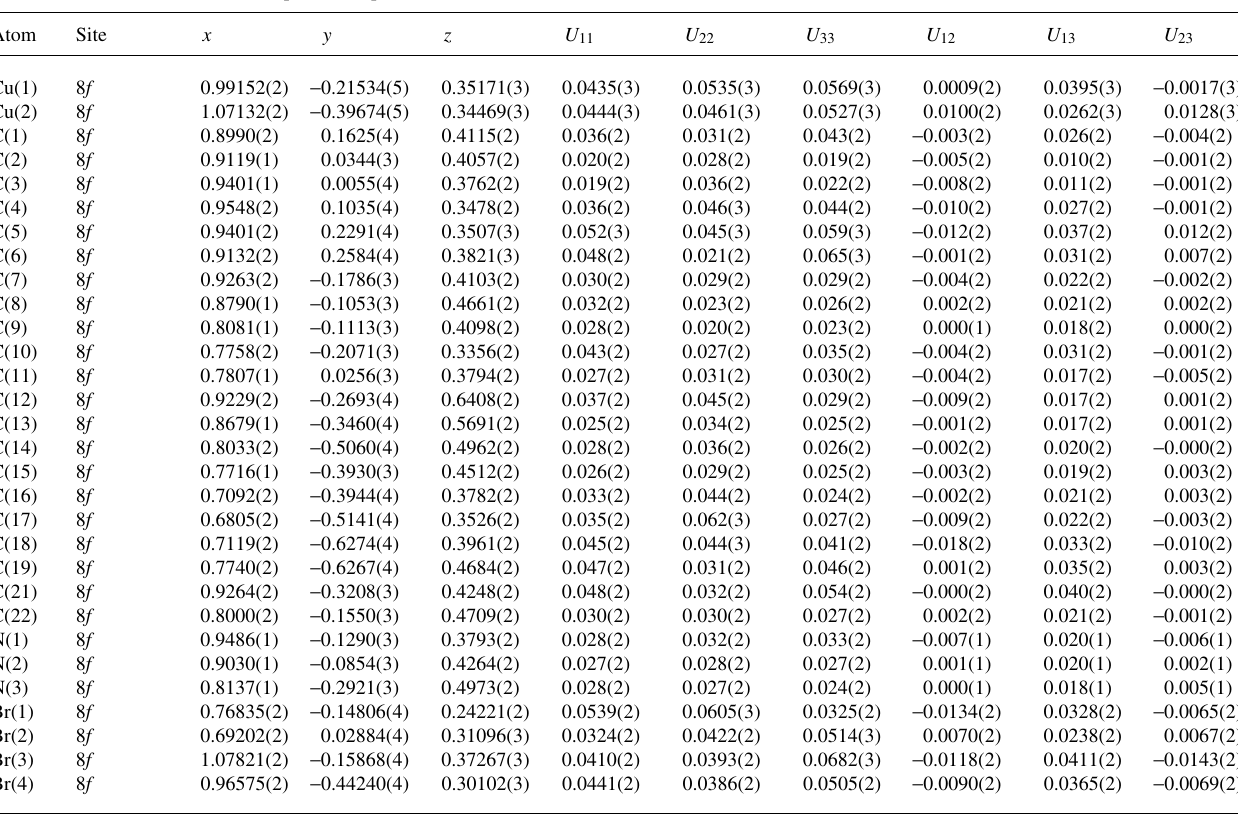
Table 3. Atomic coordinates and displacement parameters (in Å 2 )